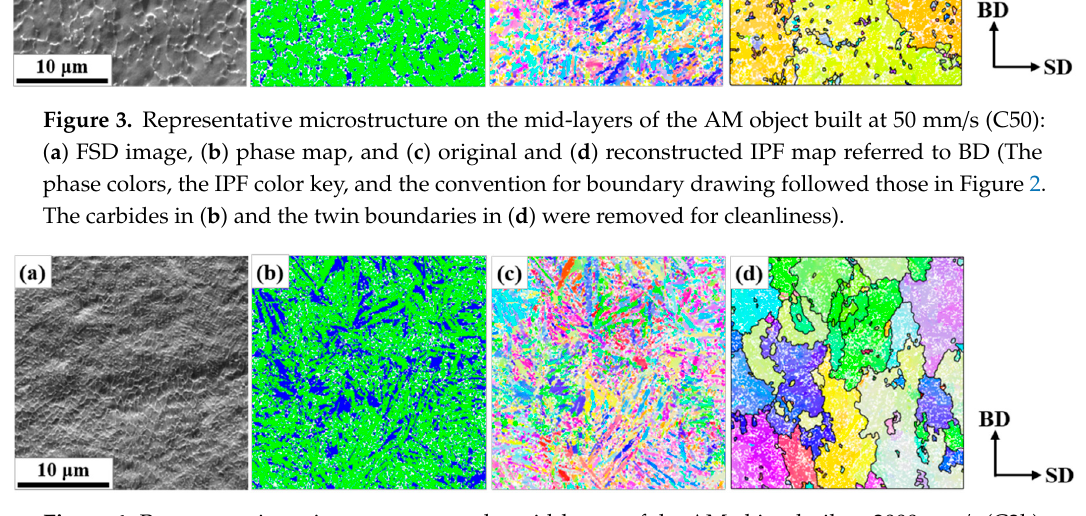
Figure 4. Representative microstructure on the mid-layers of the AM object built at 2000 mm/s (C2k): ( a ) FSD image, ( b ) phase map, and ( c ) original and ( d ) reconstructed BD-IPF map (The phase colors, the IPF color key, and the convention for boundary drawing followed those in Figure 2. The carbides in ( b ) and the twin boundaries in ( d ) were removed for cleanliness).